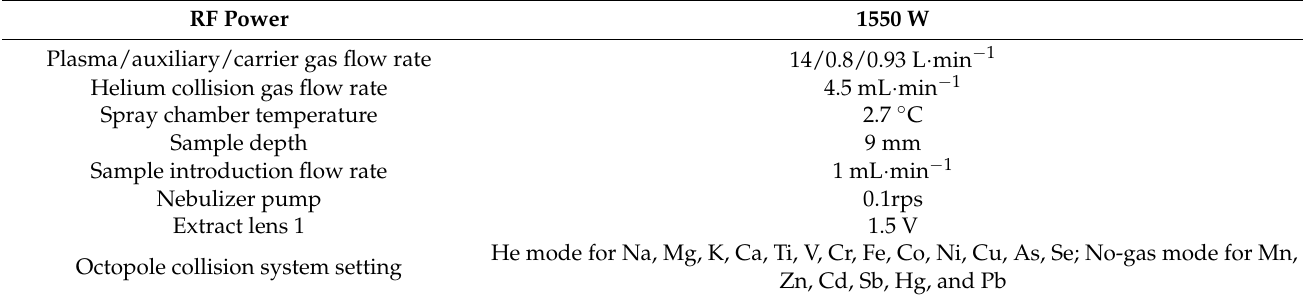
Table 1. Instrument operating parameters for inductively coupled plasma mass spectrometry (ICP-MS) analyses. RF